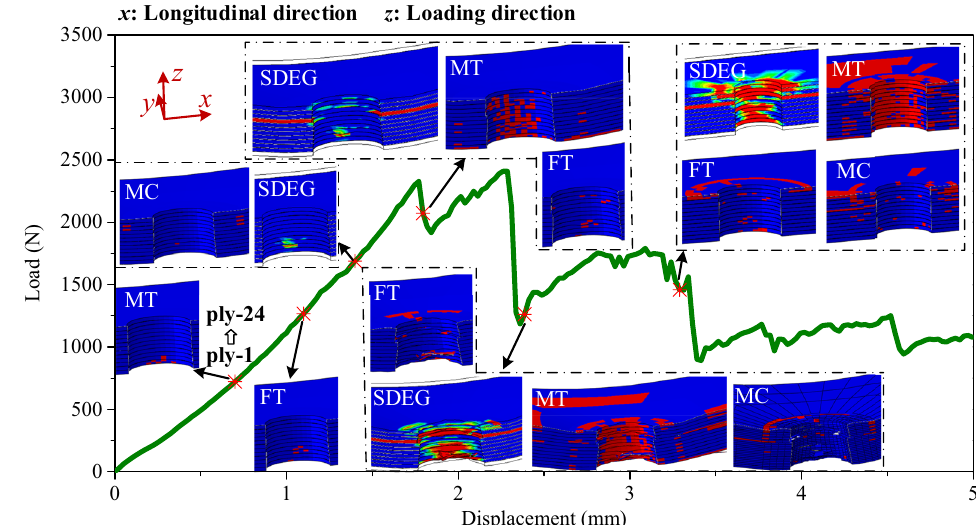
Figure 8 Progressive damage propagation of the specimen from the finite element